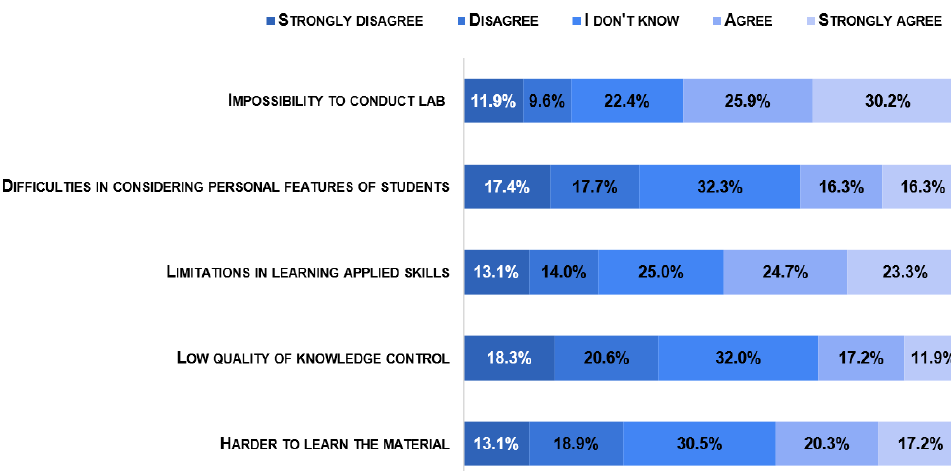
Figure 7. Difficulties in the remote format of knowledge transfer.